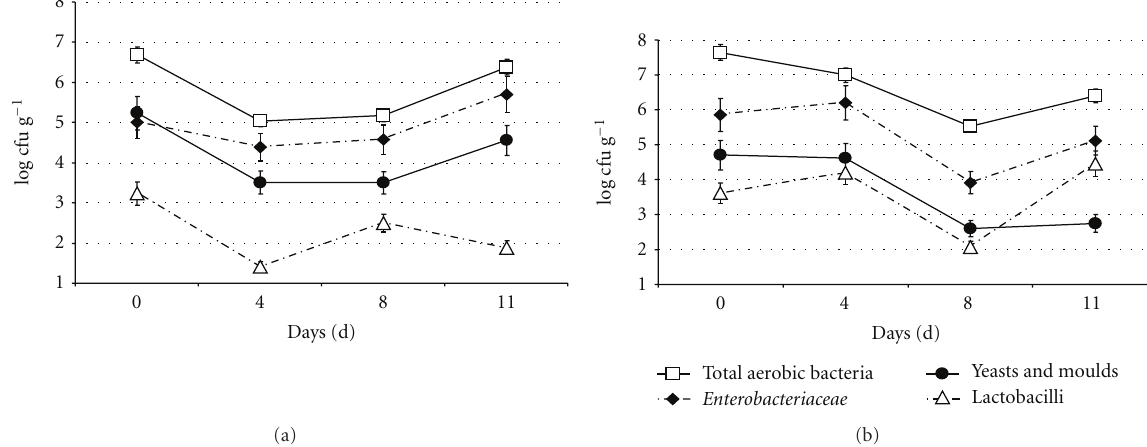
Figure 1: Growth dynamics of microbial populations from zucchini female flower pistils during cold storage at 4 ◦ C in trial A and B. Mean value ± standard deviation.